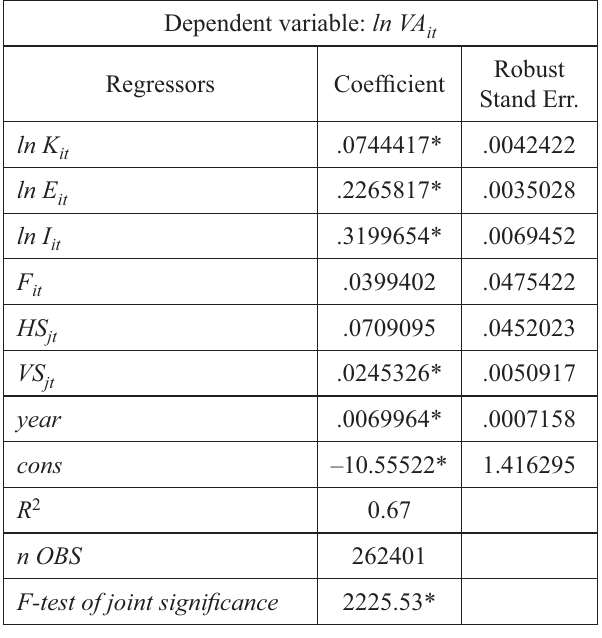
Table 3.2. Results of the Fixed Effects estimation of model